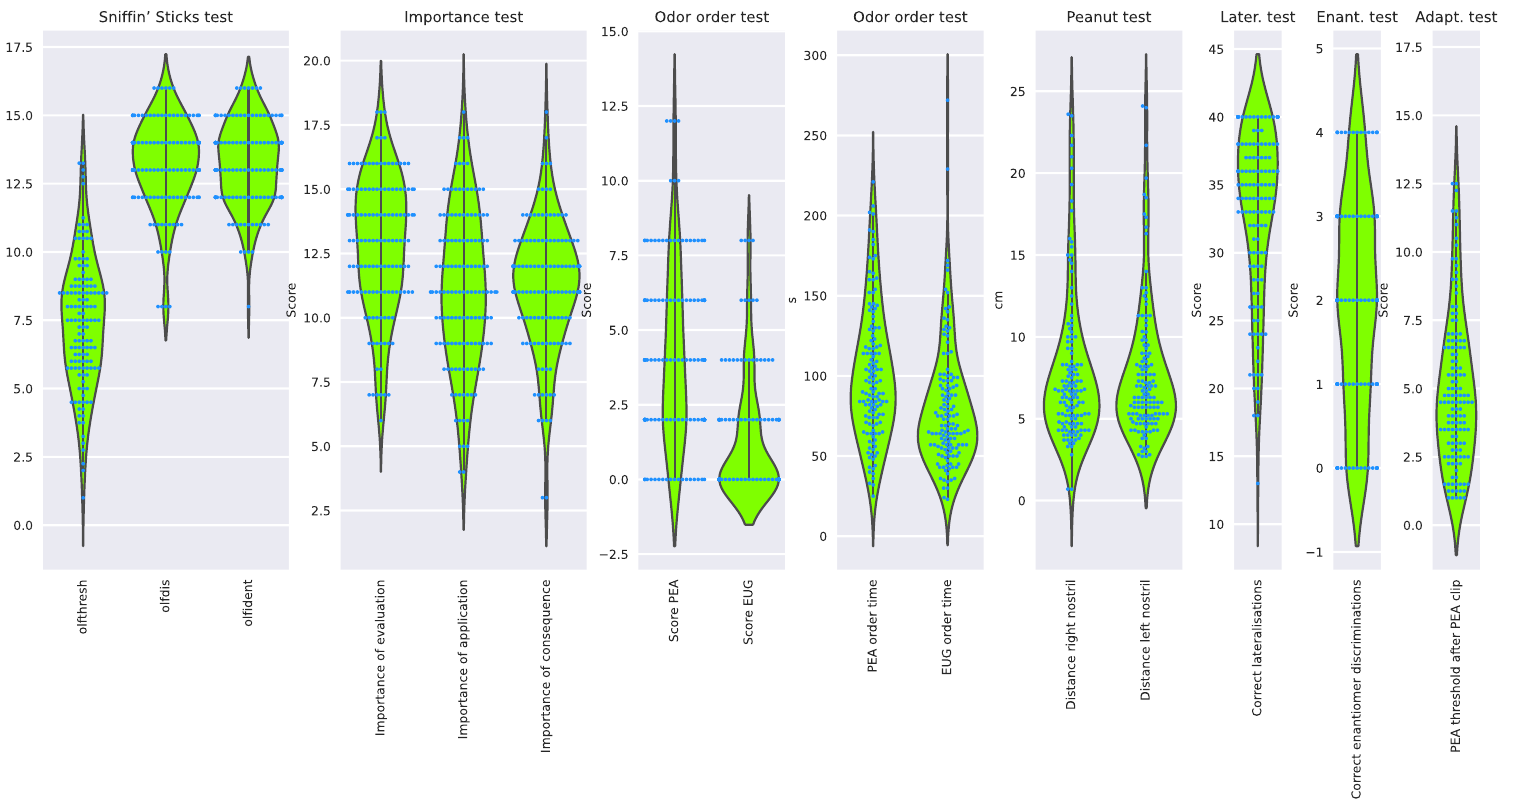
Figure 2. Raw non-transformed and non-imputed olfaction-related data acquired from n = 135 individuals. Single data points are plotted as dots on violin plots showing the probability density distribution of the variables, and in addition, boxplots provide basic descriptive statistics. Variable names, if not self-explaining: “olfthresh“ = olfactory threshold to phenyl ethyl alcohol (PEA), “olfdis” = score in the odor discrimination task, “olfident” = score in the odor identification task. Higher values indicate better olfactory performance. “log Distance right/left nostril” = perception of peanut butter odor from a distance, “Score PEA/EUG” = scores in the odor sorting tasks, “Lat correct assignments overall” score in the lateralization test. Lower values indicate better olfactory performance. The figure has been created using Python version 3.8.12 for Linux (https://www.python.org, accessed on 28 January 2022) and Seaborn Python data visualization library (https://seaborn.pydata.org, accessed on 28 January 2022 [65] ).